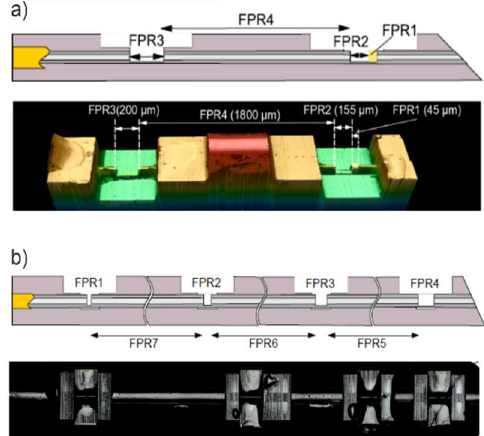
Fig. 1. Examples of two FP fiber sensors (top: schematic; bottom: confocal microscope image): (a) two RI sensors with additional Si inlay, (b) four different open-cavity RI